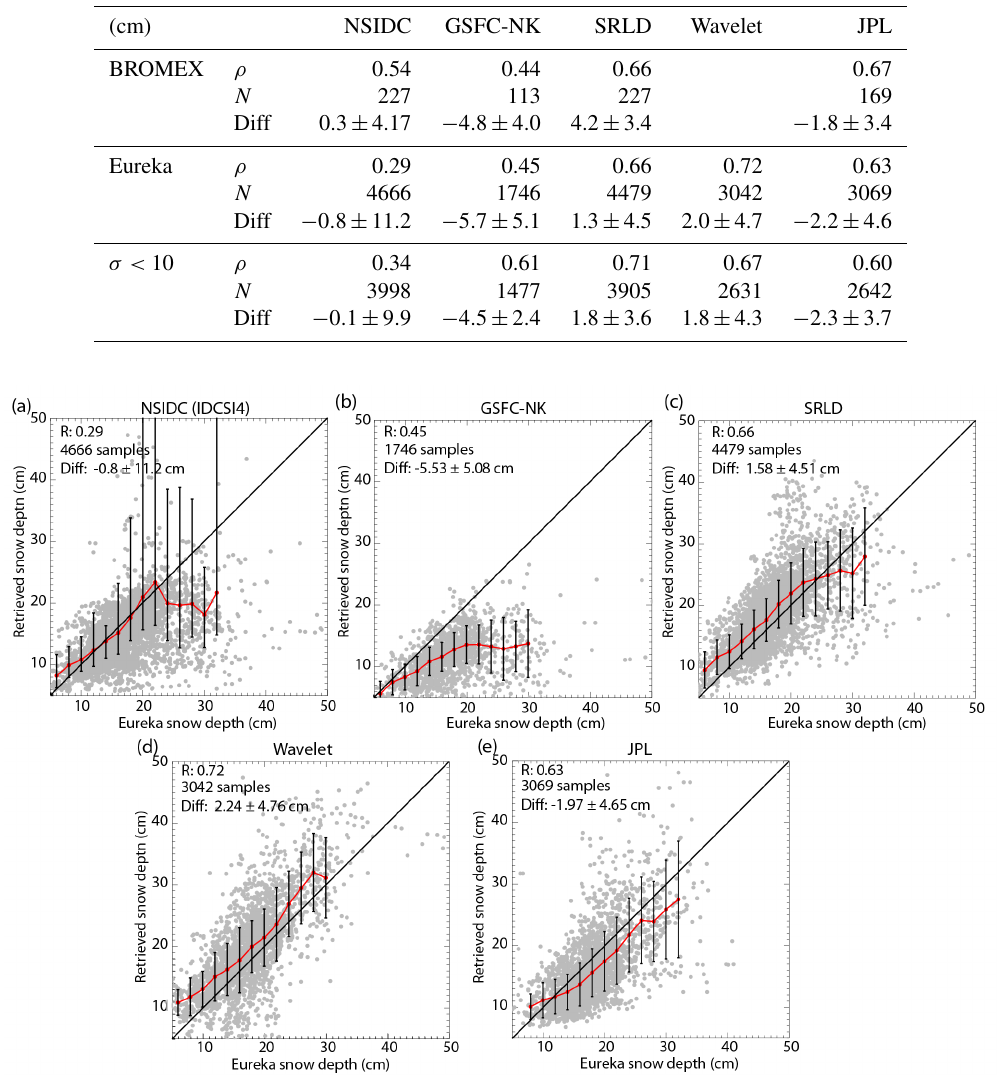
Table 3. Comparison of averaged radar snow depth with field measurements at BROMEX and Eureka. The additional comparisons at Eureka are for samples where the standard deviation of the field-measured snow depth within the averaging radius of 20m is less than 10cm.